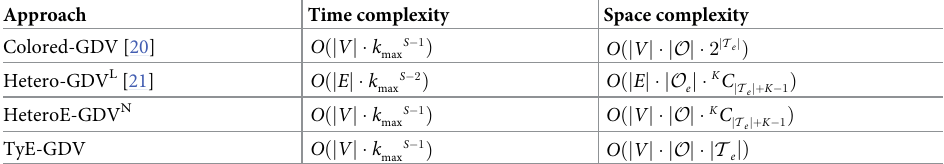
j is the number of edge-orbit e